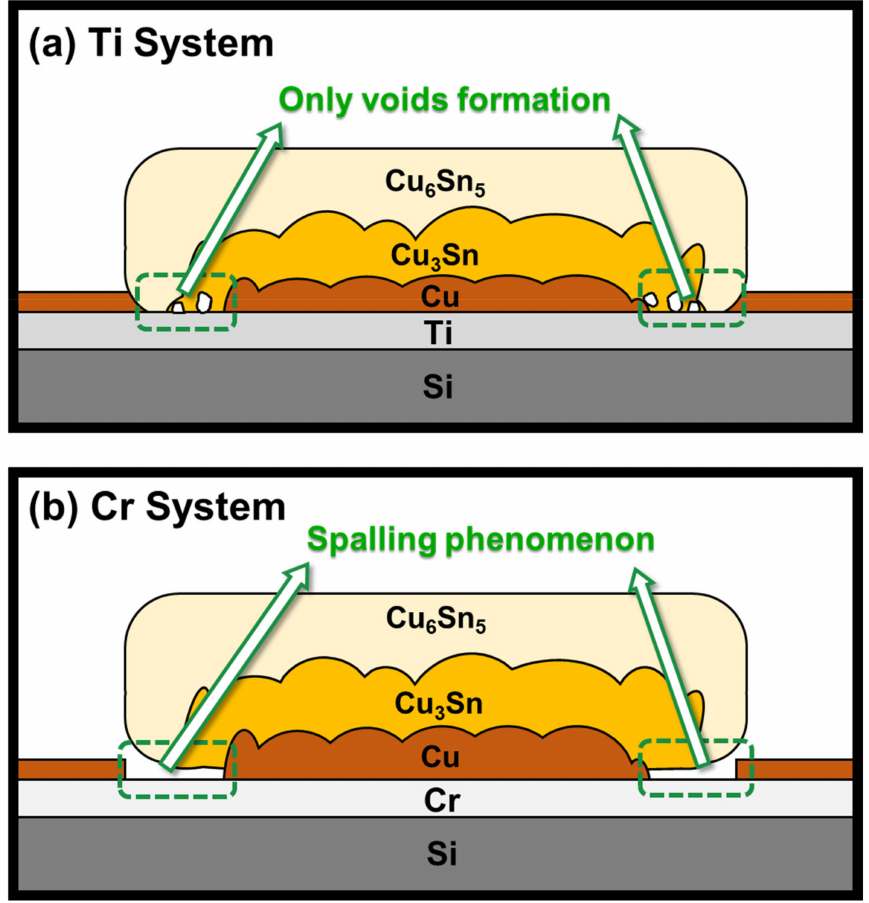
Figure 7. Schematic drawing of a Sn/Cu micro-bump ( a ) using the Ti adhesion layer; ( b ) using the Cr adhesion layer after aging at 200 ◦ C with Cu